Question: What type of chart is this?
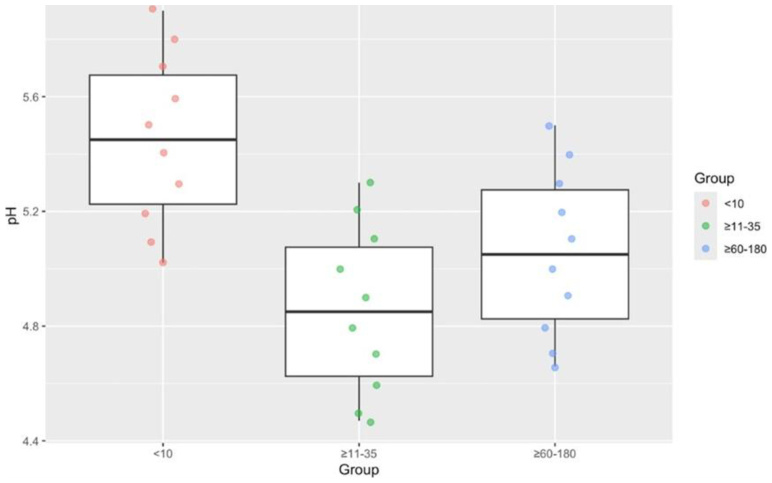
Answer: box